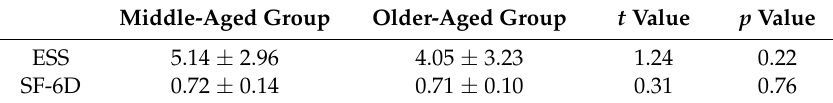
Table 2. Differences in ESS and SF-6D scores at 5 months after cardiac surgery.